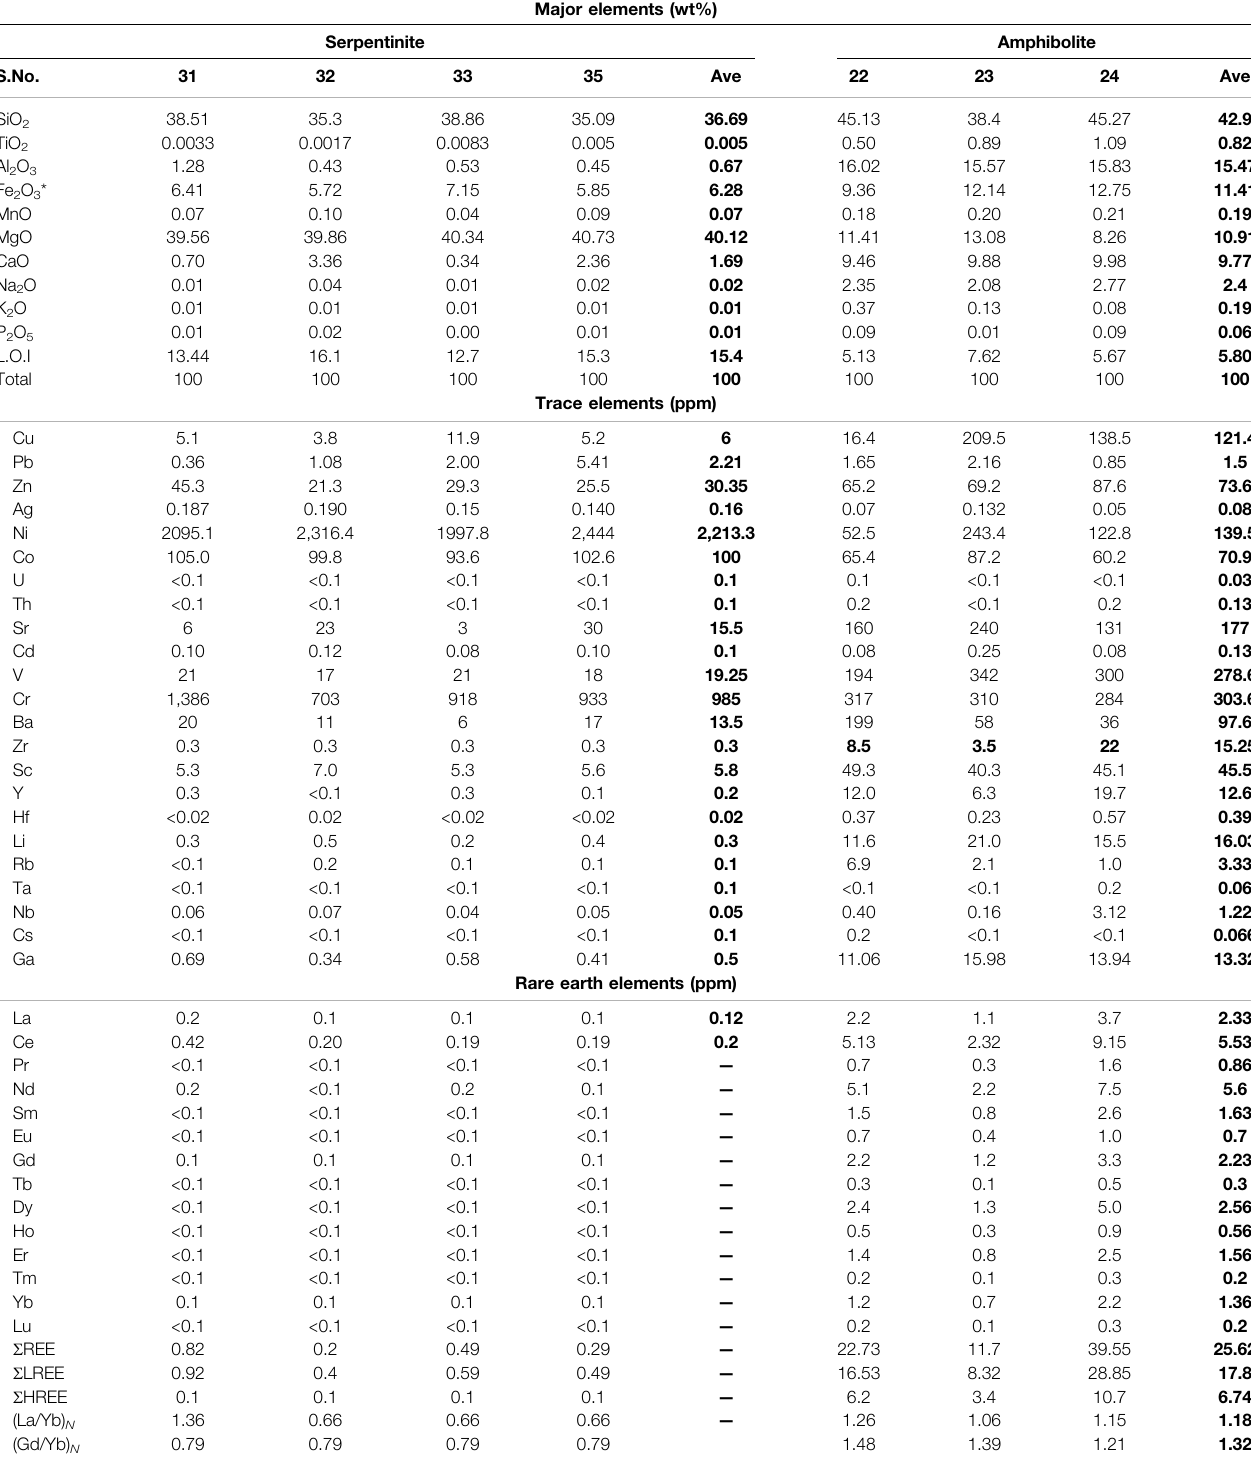
TABLE 1 | Chemical composition of the Tilal Al qulieb serpentinite and amphibolite rocks. Major elements (wt%) Serpentinite Amphibolite S.No. SiO 2